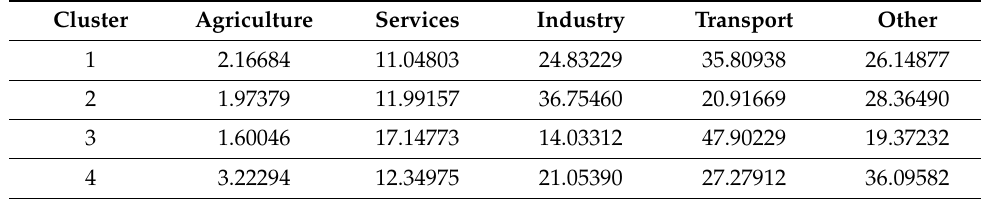
Table 5. The mean values of analysed variables in each cluster.